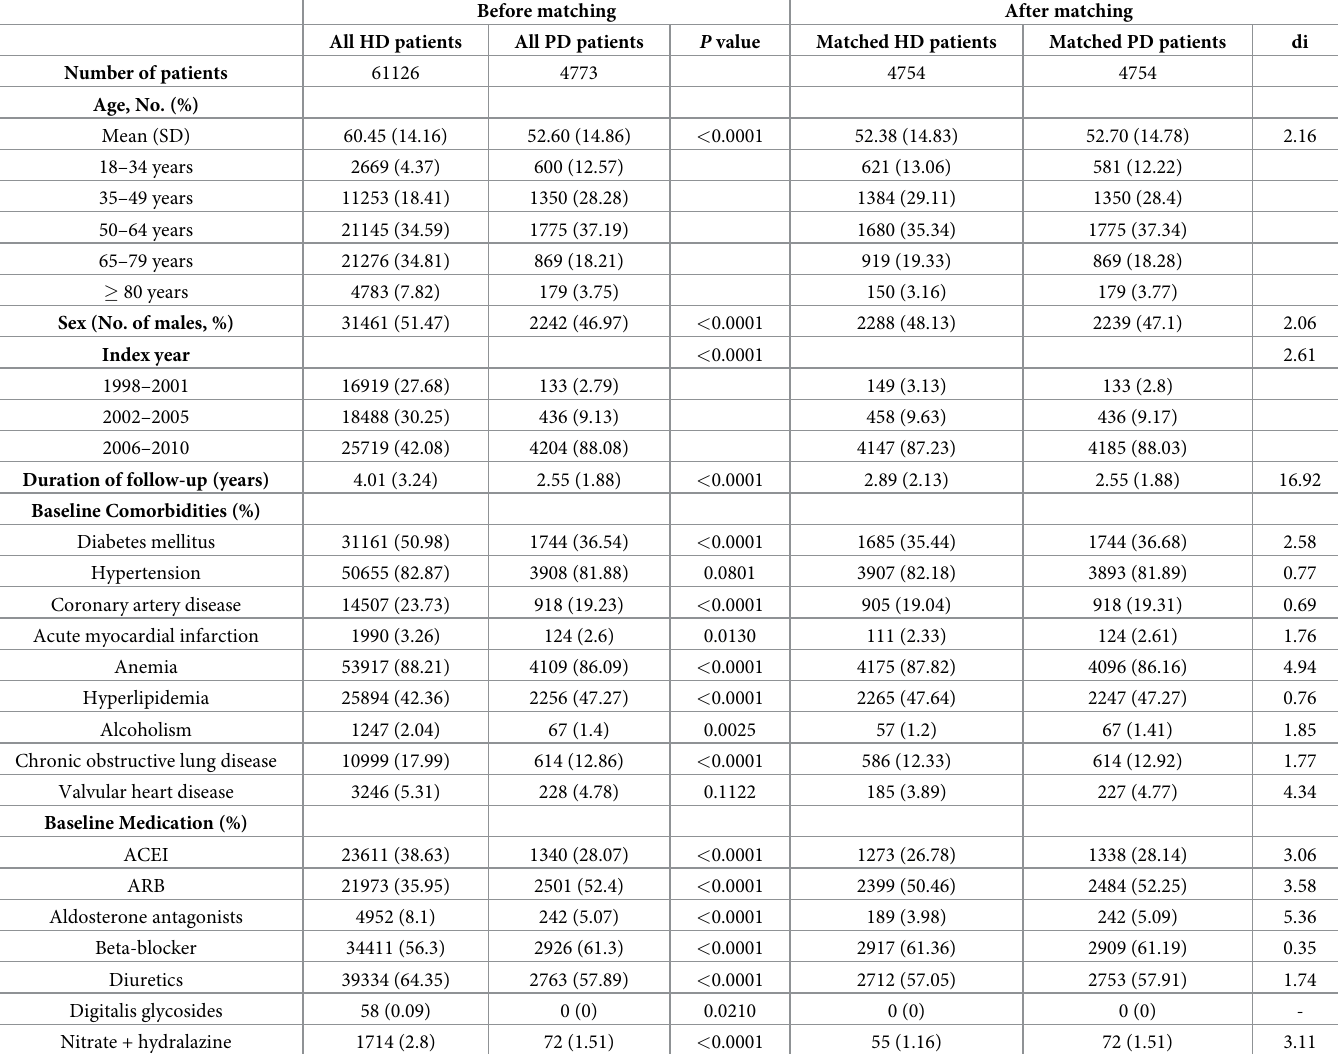
Table 1. Comparison of demographic and clinical characteristics of dialysis patients before and after matching by propensity